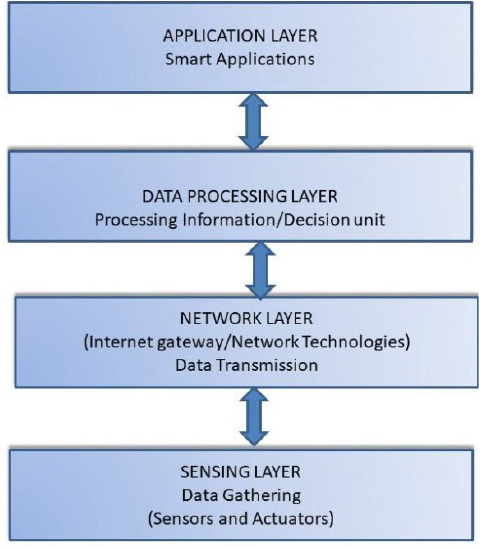
Figure 7. The fundamental architecture of IoT.